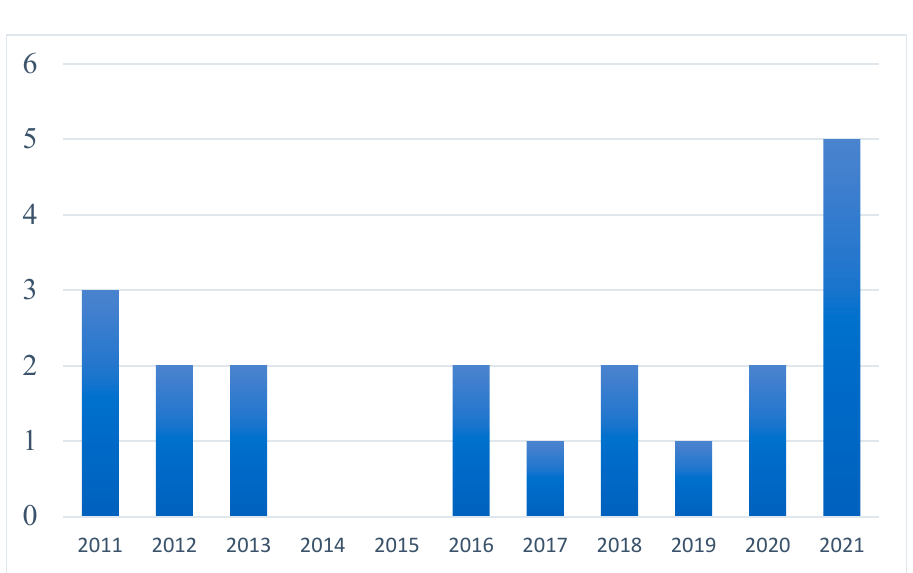
Figure 2. Studies by year of publication. Table 1. Description of the studies included in the review.